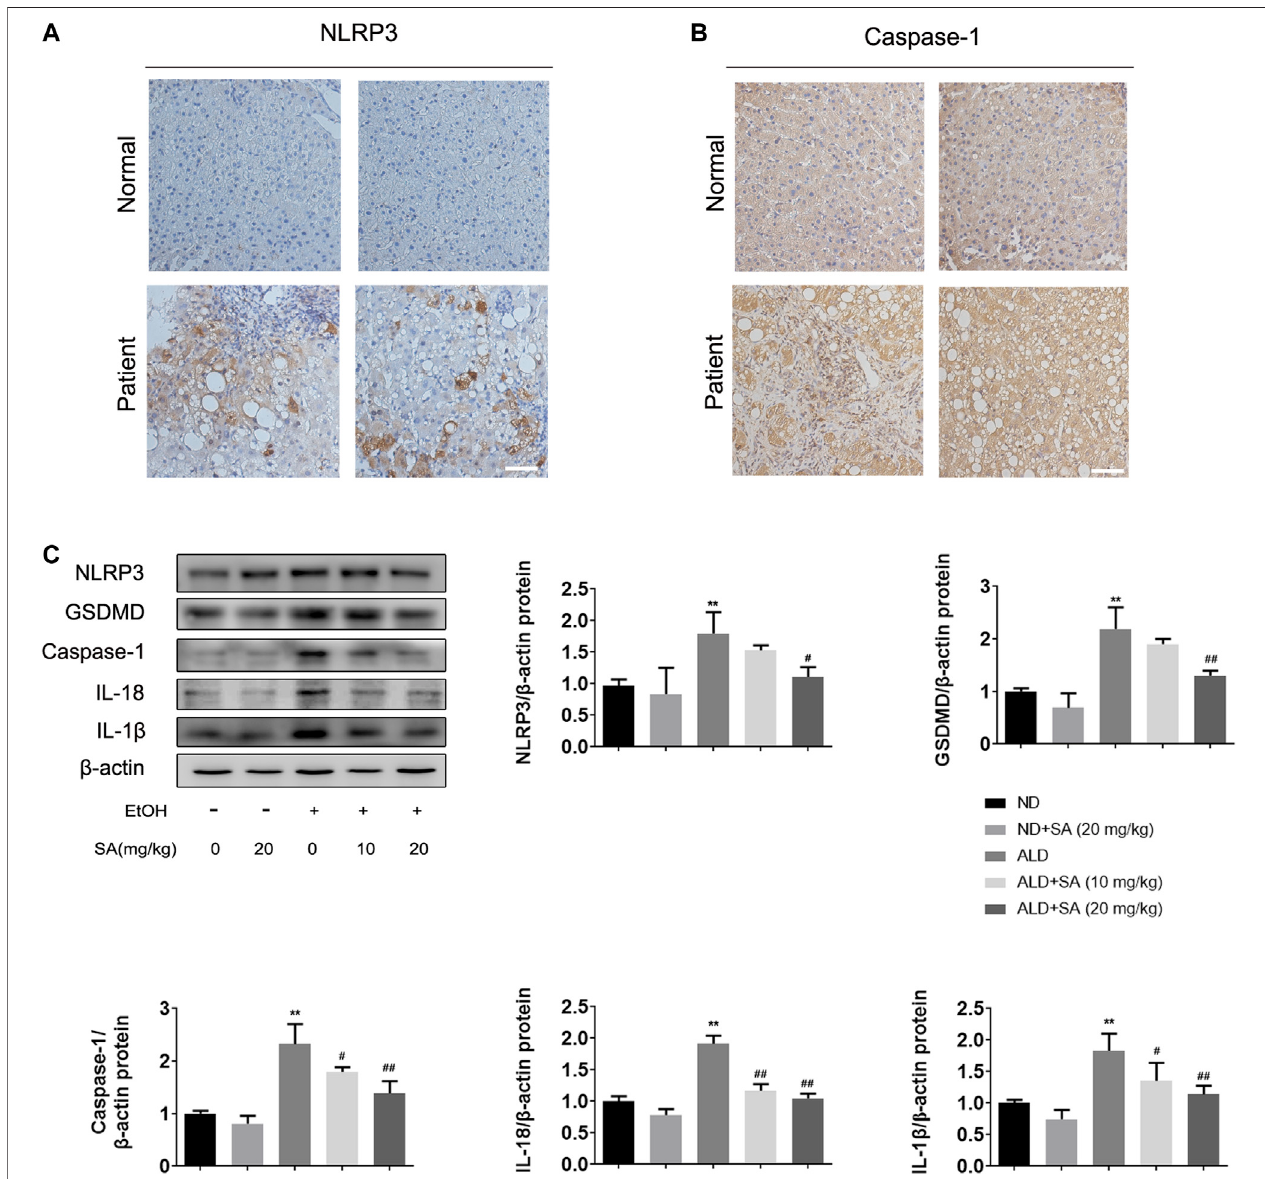
FIGURE 3 | Alcohol-induced pyroptosis is alleviated by SA (A) IHC staining for NLRP3 in fl ammasome ( × 200) (B) IHC staining for caspase-1 ( × 200). Scale bar (cid:2) 50 μ m ( n (cid:2) 3) (C) Western blottingofhepatic NLRP3,GSDMD,activated caspase-1, IL-18 and IL-1 β proteinlevels inlivers( n (cid:2) 3). ** p < 0.01 vs the ND group; # p < 0.05, ## p < 0.01 vs the ALD